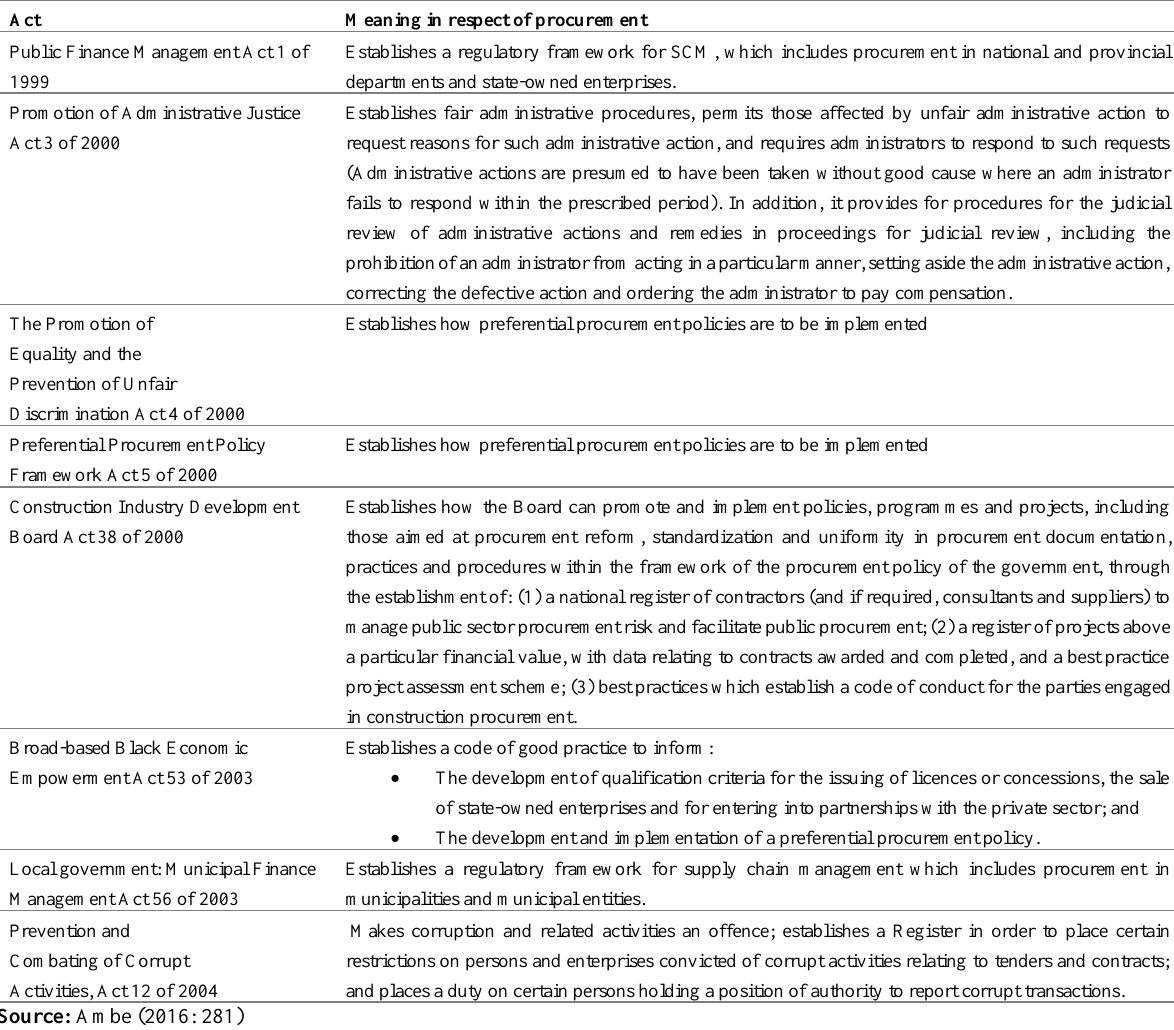
Table 1: Some of the Primary Legislations that Regulate Public